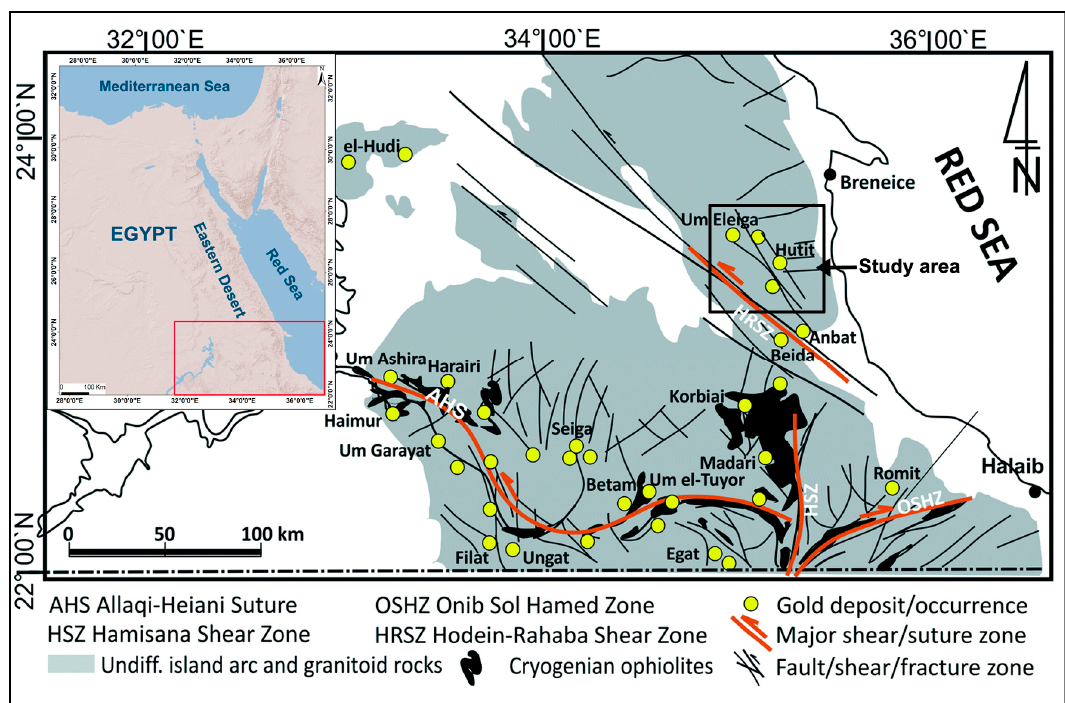
Figure 1. Simplified geological map of the South Eastern Desert (SED) of Egypt with the major Figure1. SimplifiedgeologicalmapoftheSouthEasternDesert(SED)ofEgyptwiththemajordeformation deformation systems and gold occurrences shown. systems and gold occurrences